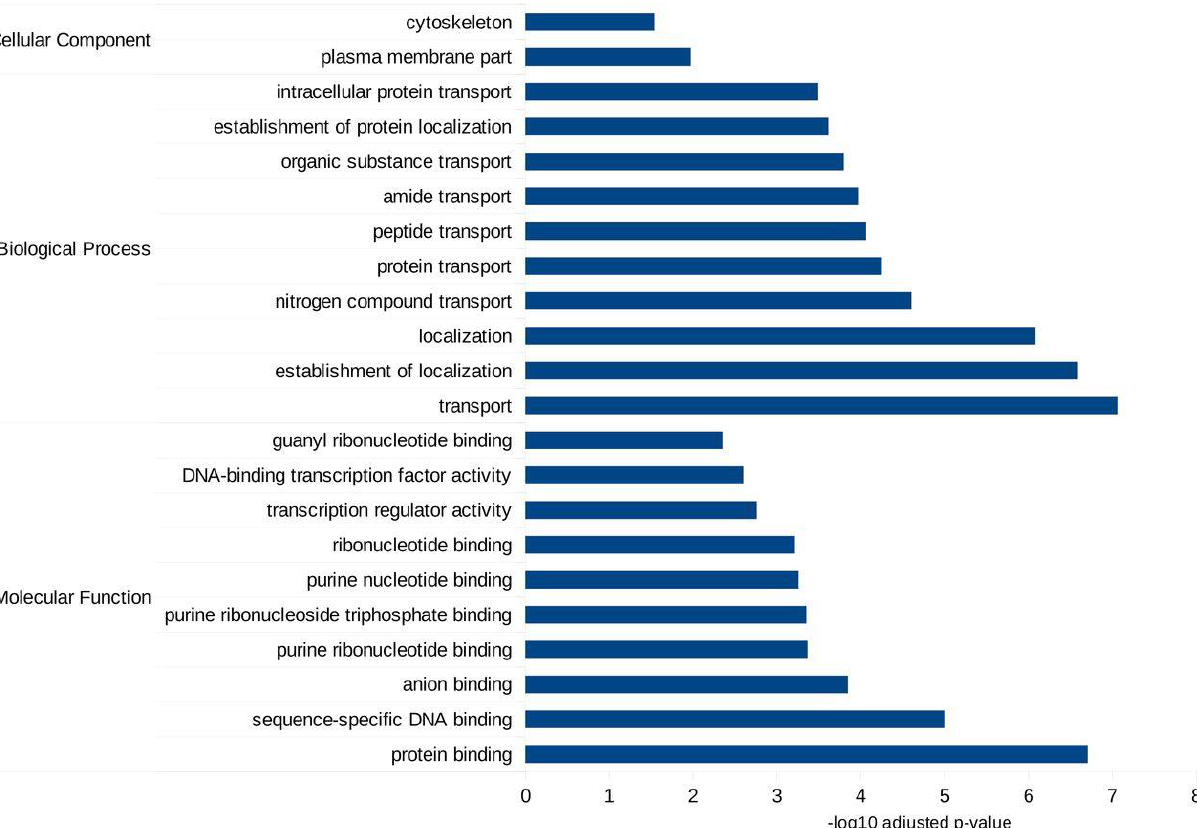
Figure 5. GO bar graphs of target genes of the differentially expressed miRNAs. Only the top 10 GO terms were plotted in the bar graphs.